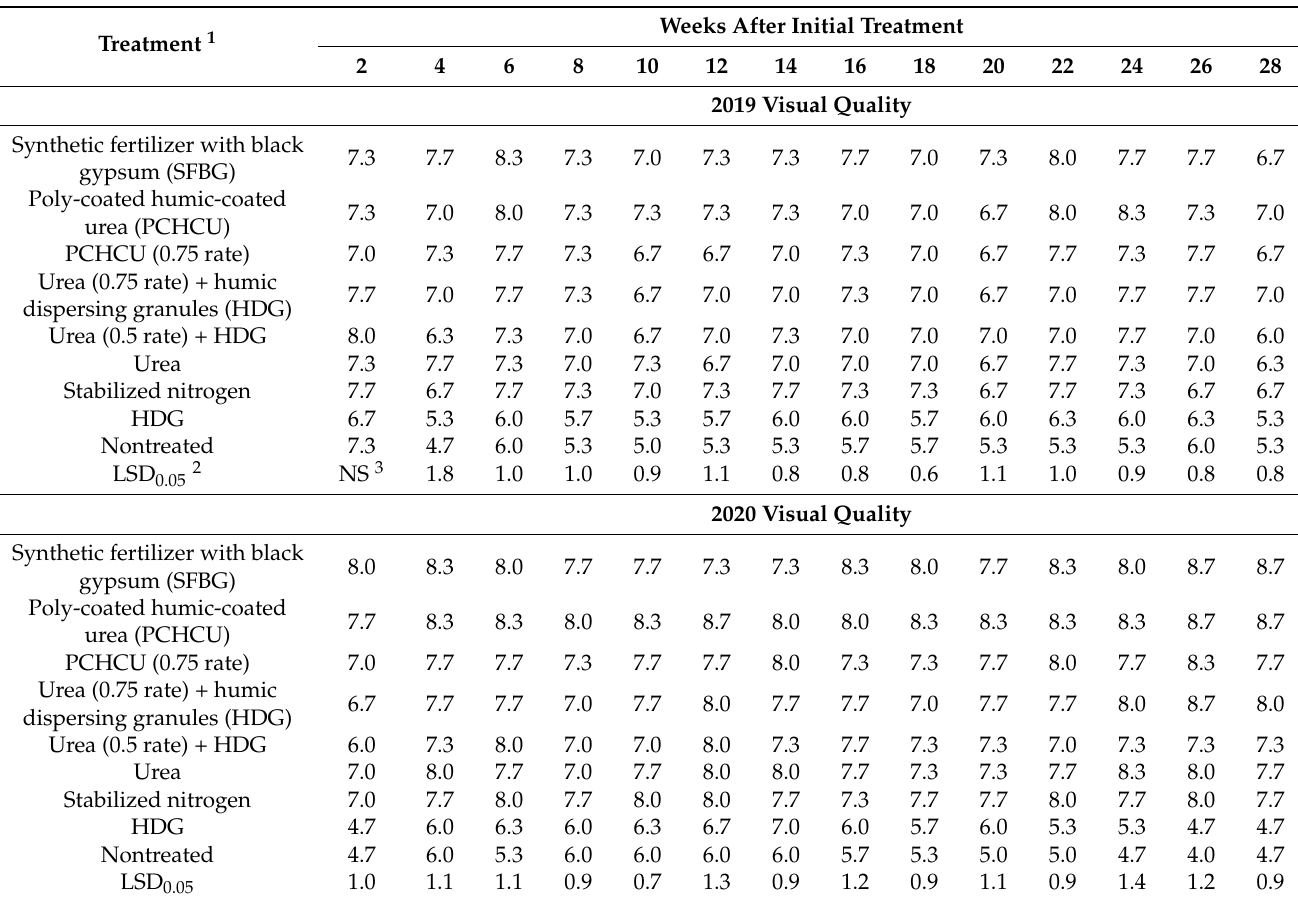
that had N, including the treatments with reduced N rates, outperformed HDG and the nontreated control for visual quality. Table 3. Effects of various fertilizers on visual quality ratings (1-9 scale where 1 = poor and 9 = ideal, 6 or above being acceptable) of a native soil Kentucky bluegrass maintained at 7.6 cm in Ames, IA, USA in 2019 and 2020. Treatment